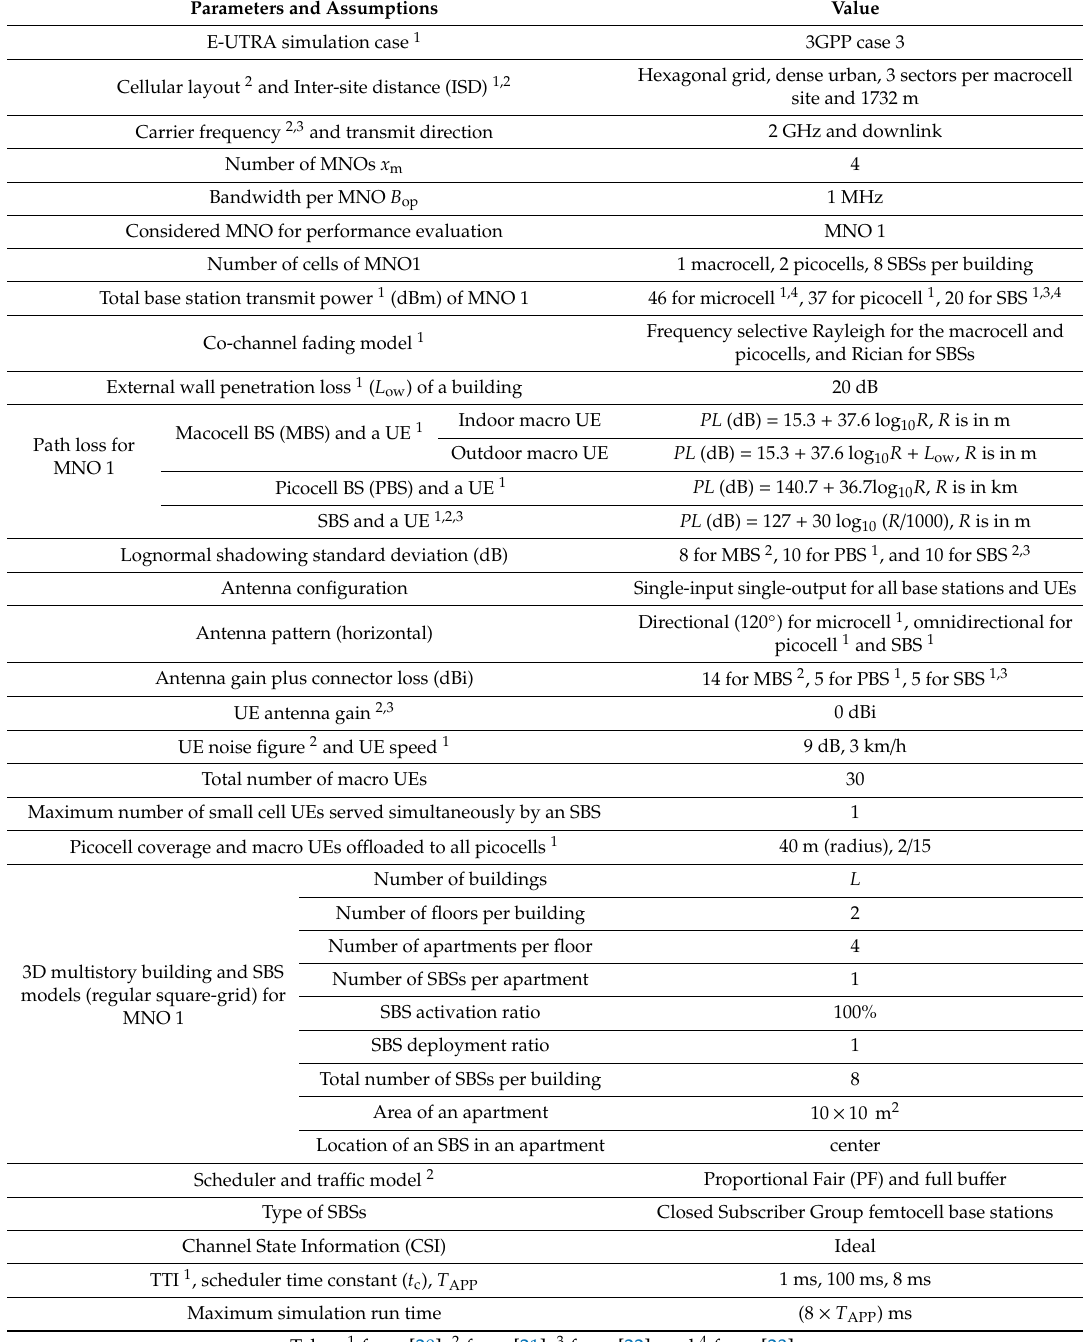
Table 1. Default parameters and